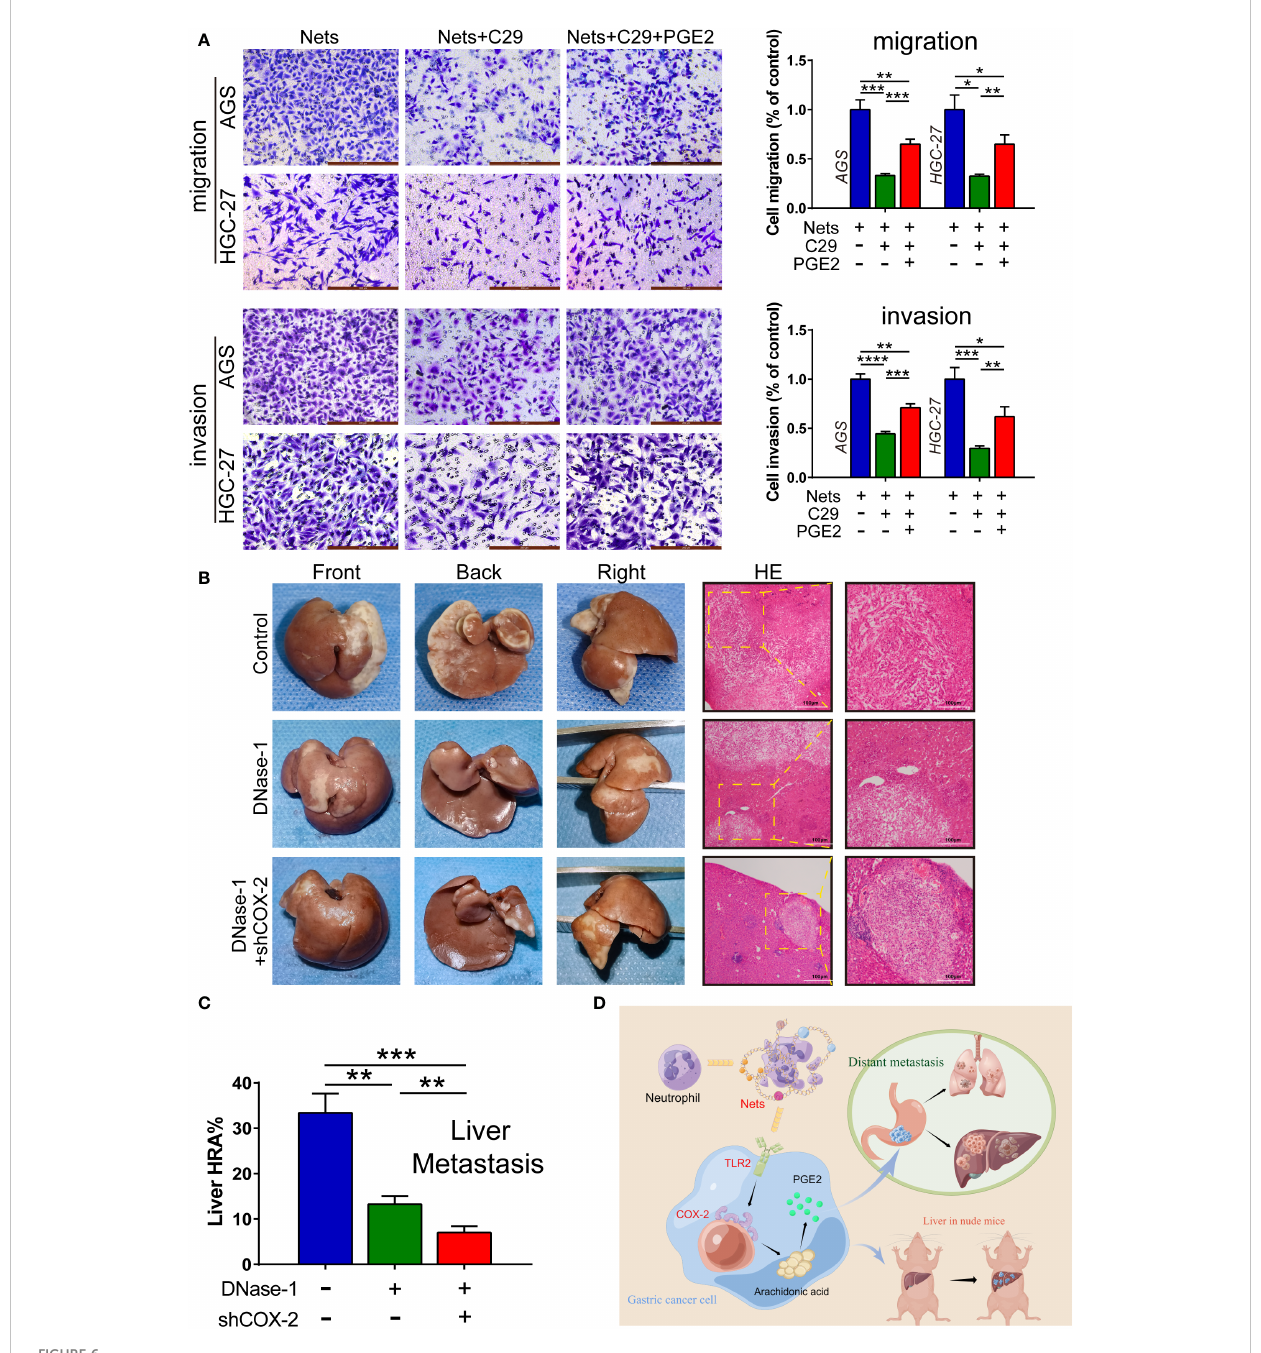
FIGURE 6 NETs act on COX-2 via TLR2 to promote GC metastasis. (A) The number of cells affected by NETs passing through membrane was measured by migration and invasion assays with the intervention of C29 and PGE2, which were observed after staining. (*p<0.05; **p<0.01; ***p<0.001; ****p<0.0001; n=3) (B, C) Dnase-1 was injected into mice to inhibit NETs. HGC-27 cells transfected with shCOX-2 or negative control shNC were implanted in the spleen of mice. The proportion of liver tissue replaced by hepatic metastatic tumor was counted as the liver replacement area (HRA %). (**p<0.01; ***p<0.001; n=3) (D) The illustration of NETs promoting gastric cancer metastasis by regulating COX-2. (This picture is authorized by the Figdraw platform. ID: SUWSO44938). All results are presented as mean ±